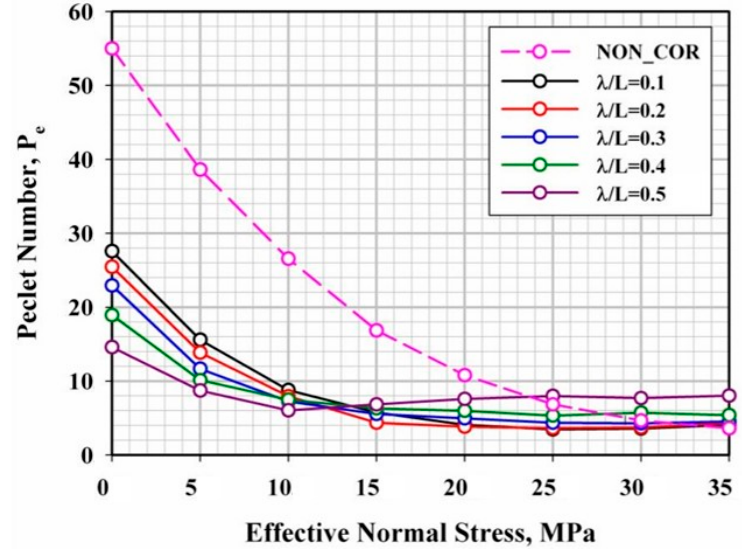
Figure 11. Comparison of Peclet numbers based on λ / L and σ (cid:48)